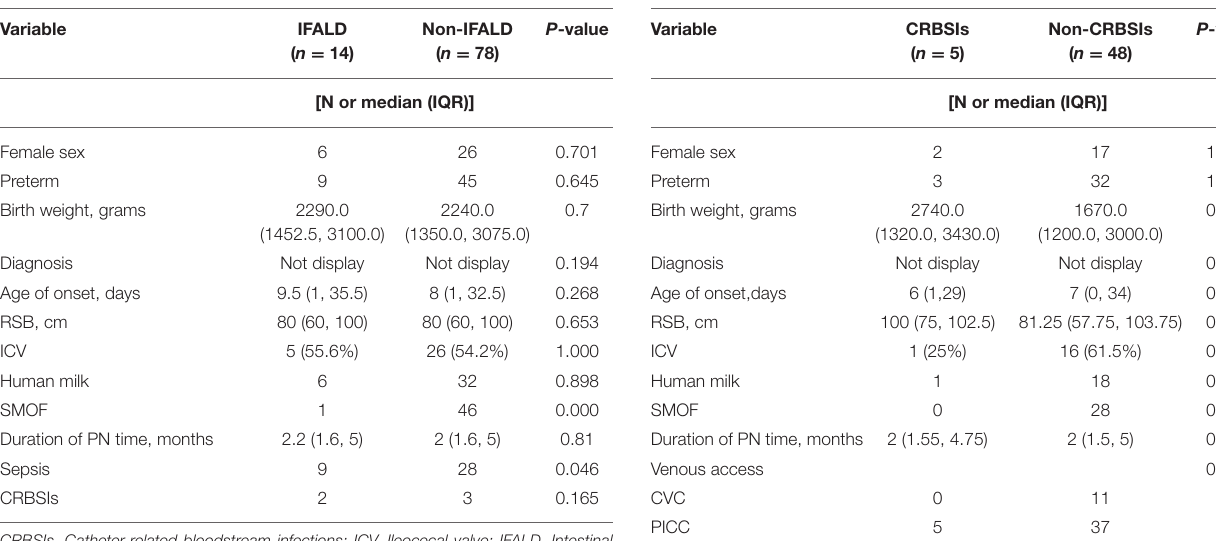
TABLE 5 | Single factors analysis of IFALD in children with Intestinal Failure. TABLE 6 | Single factors analysis of CRBSIs in children with intestinal